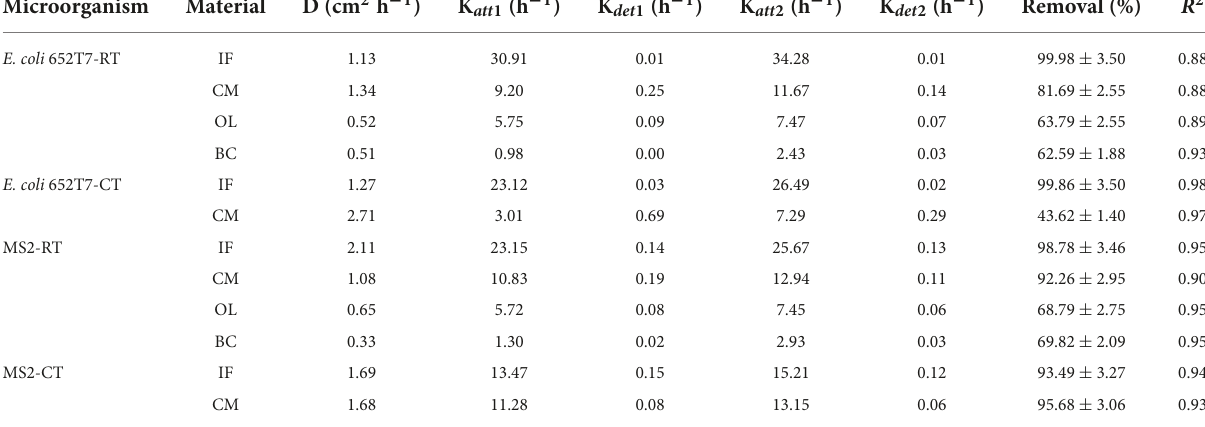
TABLE 2 Experimental and fitted model parameters of respective transport (RT) and co-transport (CT) column experiments. Microorganism Material